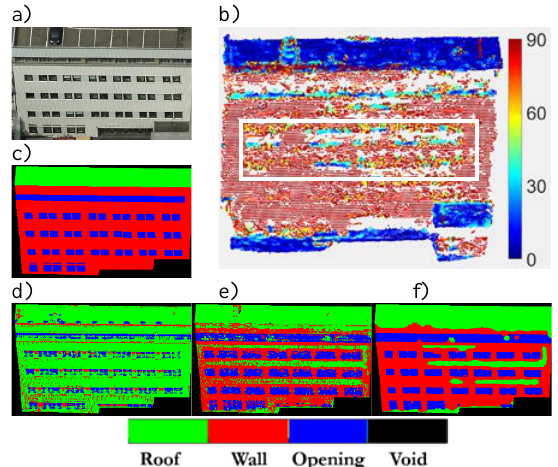
Figure 7 Misclassification caused by inaccurate dense matching point cloud. a) façade image, b) façade point cloud, color representing the angle ( o ) between normal vector and z-axis, c) ground truth, d) results from random forest using 2D features, e) results from random forest using 2D and 3D features, f) results from fully connected Table 2 Pixelwise accuracy of random forest using only 2D features.